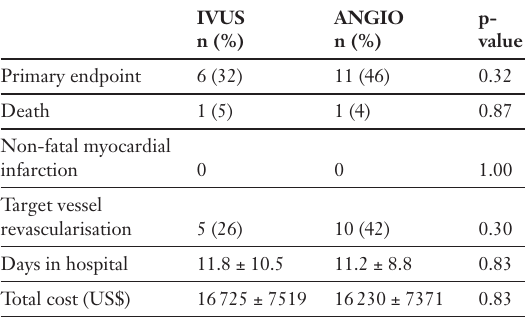
Outcomes during 2-year